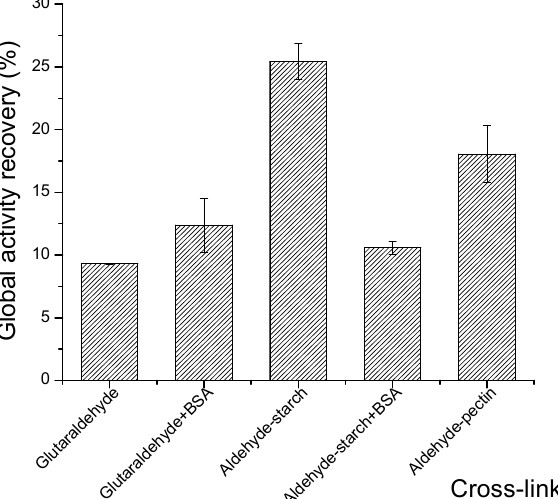
Figure 4. Effect of different cross-linkers on the global activity recovery of CLEAs of CGTase. Reaction conditions: enzyme solution prepared in 50 mM sodium citrate buffer pH 6.0, precipitation with acetone (75% volumetric concentration, 20 °C, 1 h) in the absence or presence of bovine serum albumin (BSA) as co-feeder (enzyme/BSA mass ratio of 1:1); crosslinking at 20 °C for 3 h under 200 rpm stirring.